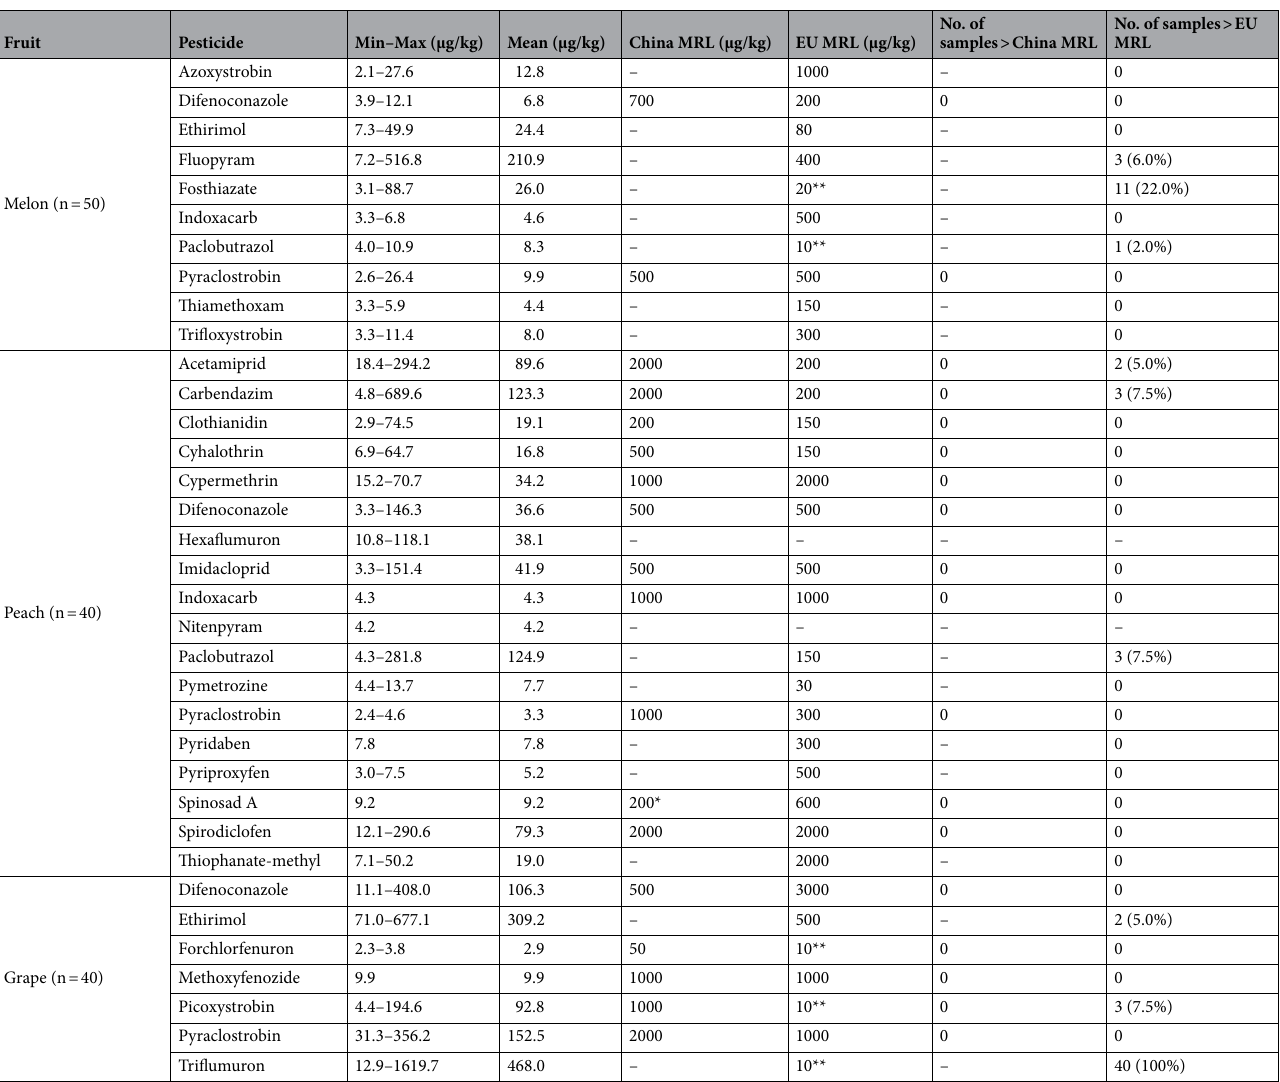
Table 1. Occurrence of pesticide residues in fruit samples. # Sum of spirotetramat and spirotetramat-enol, expressed as spirotetramat. *Temporary MRLs prescribed by the National Standard of China. **Lower limit of analytical determination prescribed by the